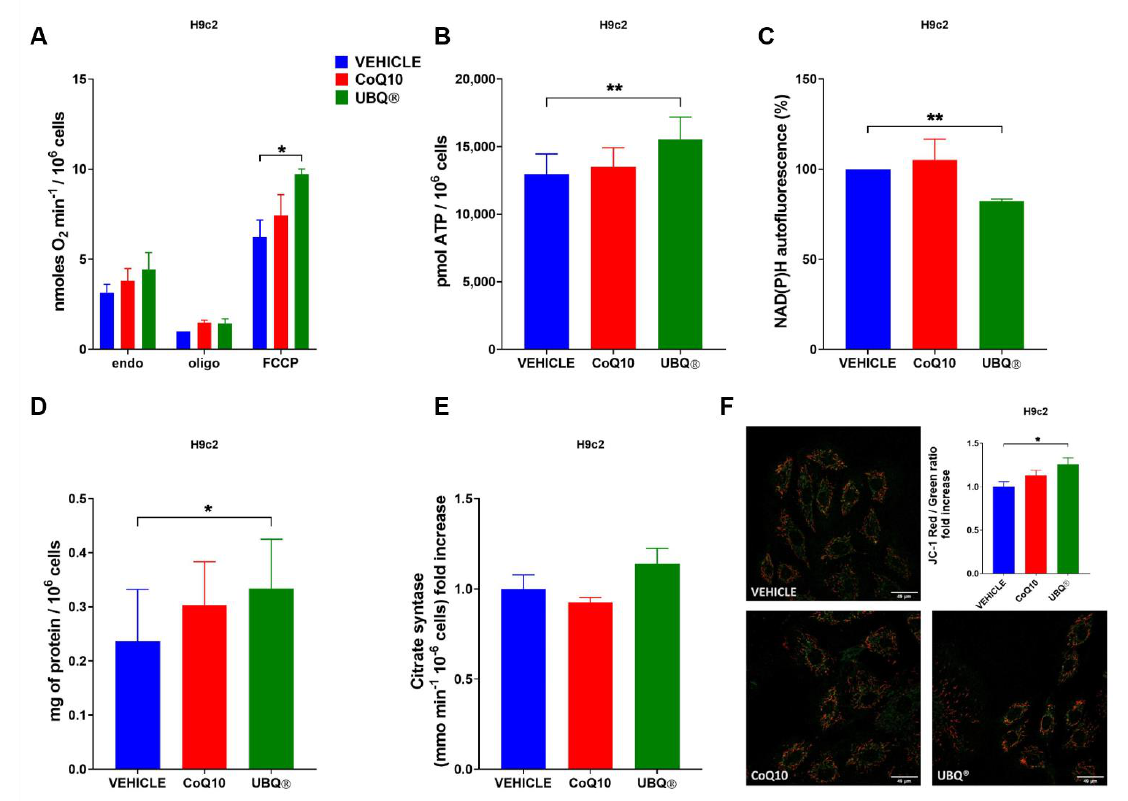
Figure 3. Bioenergetic effects of UBQ treatment in H9c2 cells. Cells were incubated with 100 nM CoQ10 phytosome (UBQ), native CoQ10 (Q10) and phytosome (vehicle) as described in the materials and methods section. ( A ) Mitochondrial Oxygen consumption rate in intact cells (endogenous respiration, endo) in the presence of 1 µ M oligomycin A (oligo) and 0.25–1 µ M carbonyl cyanide 4-(trifluoromethoxy) phenylhydrazone (FCCP). Data are expressed as nanomoles of oxygen per minute and normalized to cell number; ( n = 3). ( B ) Total cellular ATP quantification in cell lysate; ( n = 3). ( C ) NAD(P)H autofluorescence determination in intact cells. Data were normalized to cell number and expressed as a percentage of vehicle-treated sample fluorescence signal; ( n = 3). ( D ) Total protein content determination normalized to cell number; ( n = 3). ( E ) Citrate synthase activity determination normalized to cell number. Data are shown as fold increase over the vehicle-treated sample; ( n = 3). ( F ) Representative micrographs of intact cells stained with the fluorescent dye JC-1. For each condition, at least three fields were randomly selected. Quantitative analysis of Red/Green fluorescence ratio was performed using the ImageJ software. Data are presented as Red/Green fluorescence ratio fold increase over the vehicle-treated sample; ( n = 5). For all panels, data are presented as the mean ± s.e.m, * p ≤ 0.05; ** p ≤ 0.01. Statistical analysis was performed using one-way ANOVA followed by Tukey’s honest significant difference